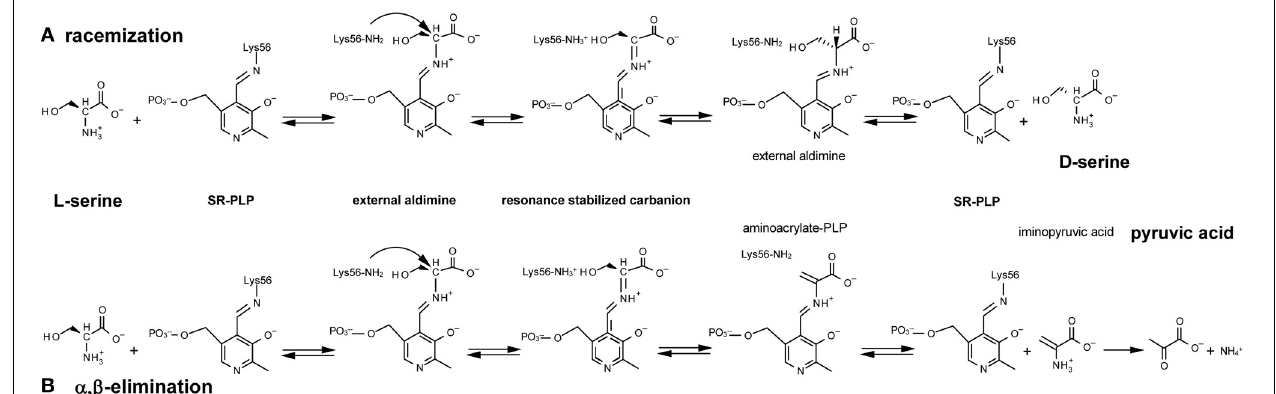
FIGURE 1 | Reactions catalyzed by serine racemase: (A) racemization; (B) α , β -elimination. Lys56 of SR binds the PLP cofactor, forming an internal aldimine; then SR reacts with L-serine to yield an external aldimine; α -proton